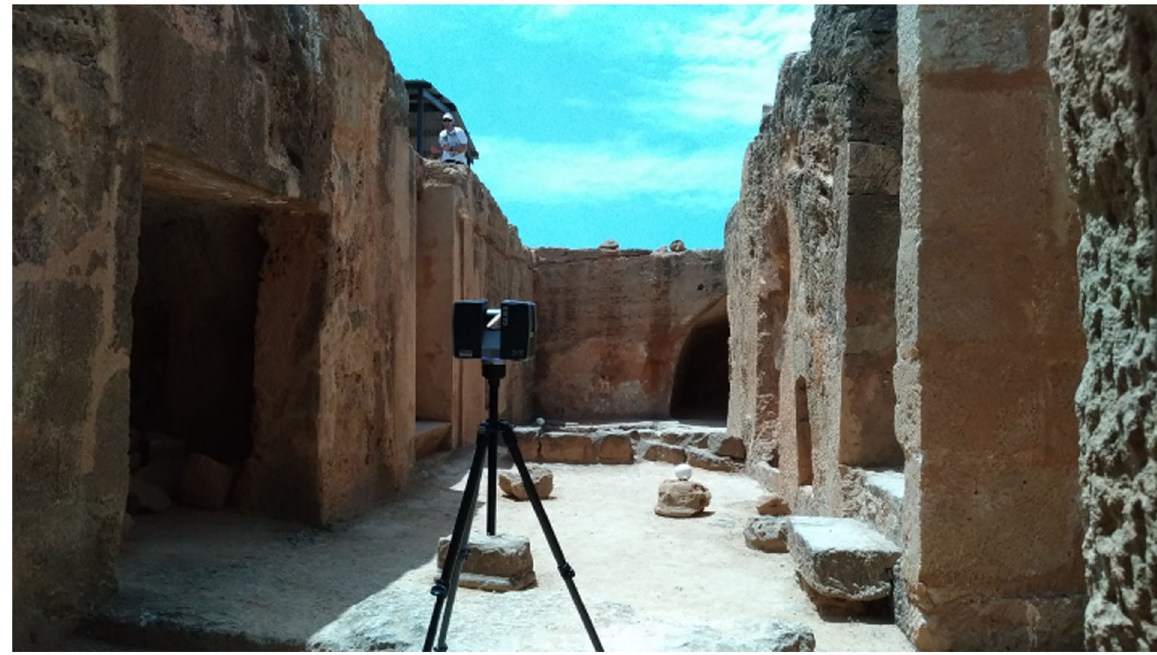
Fig. 1 3D scanning underground cavities of the Tomb of the Kings, Cyprus (2019) (Source: the authors)